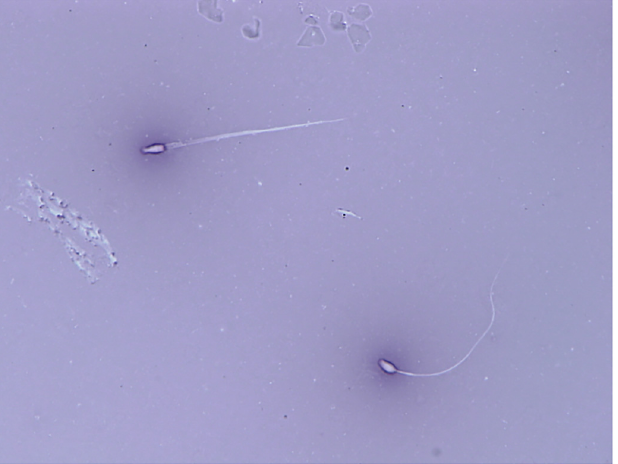
Fig 3. Normal morphology of Ansell ’ s mole-rat sperm. The samples were obtained by electroejaculation (light microscopy, magnification 600x, oil immersion, eosin & nigrosin staining).